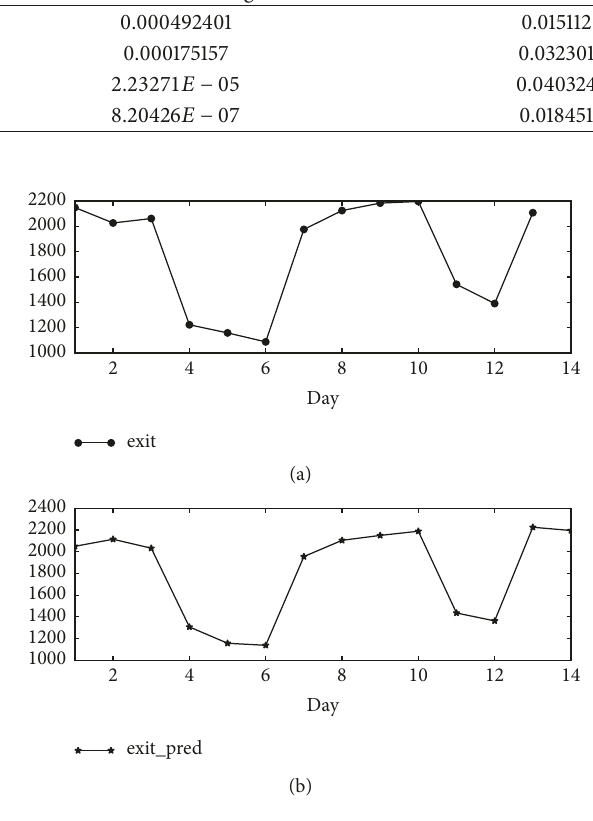
Figure 12: Prediction of daily exit passenger flow of Wuwei rail transit station (multiple linear